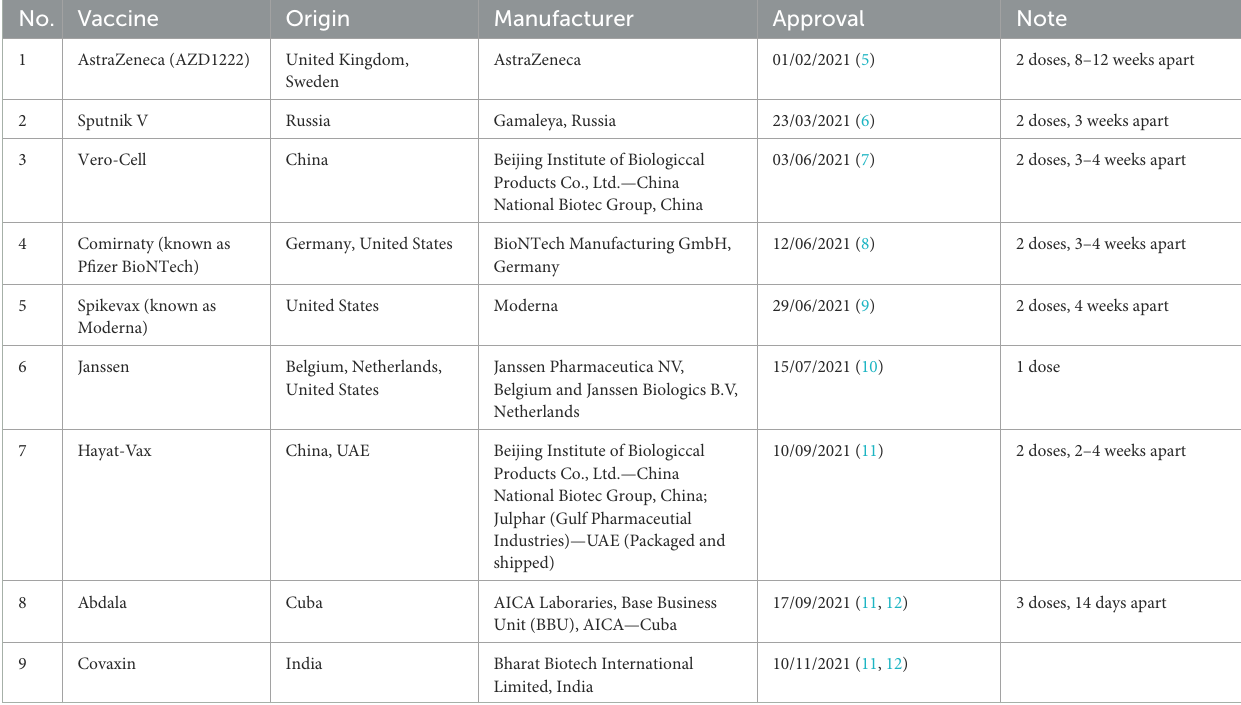
TABLE 2 Description of COVID-19 vaccines approved in Vietnam. No.